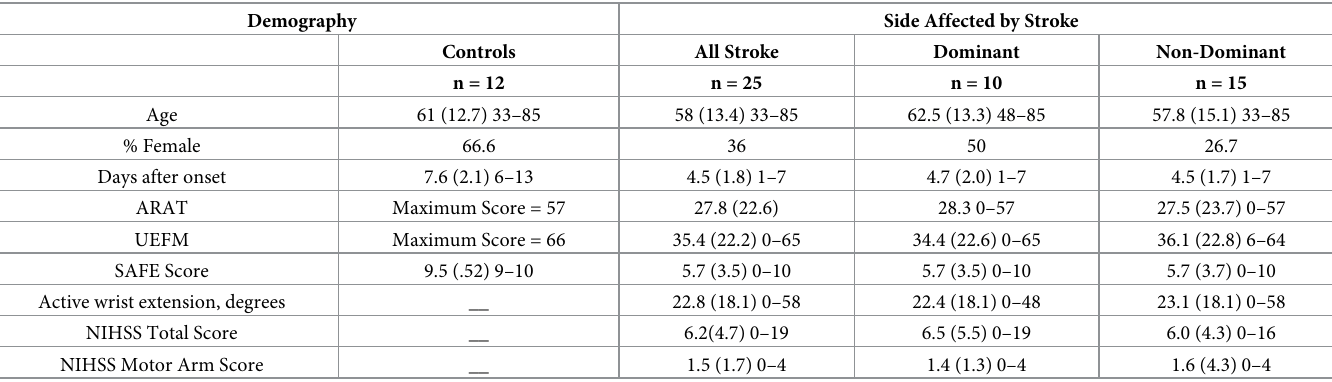
Table 1. Participant characteristics.